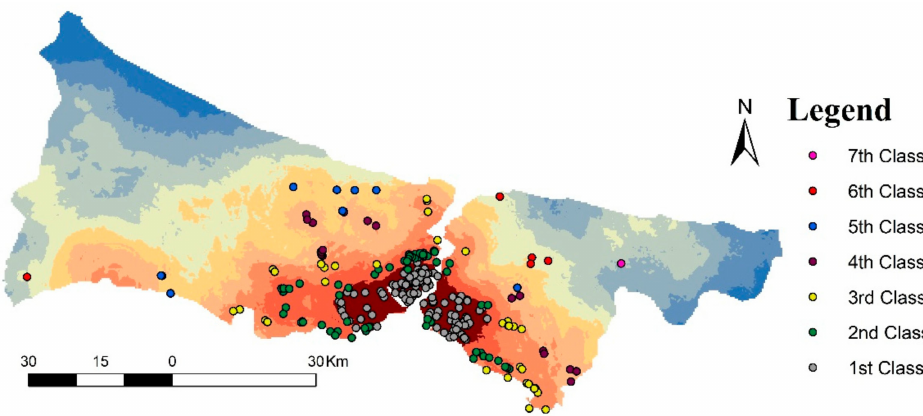
Figure 9. Distribution of EVCS by